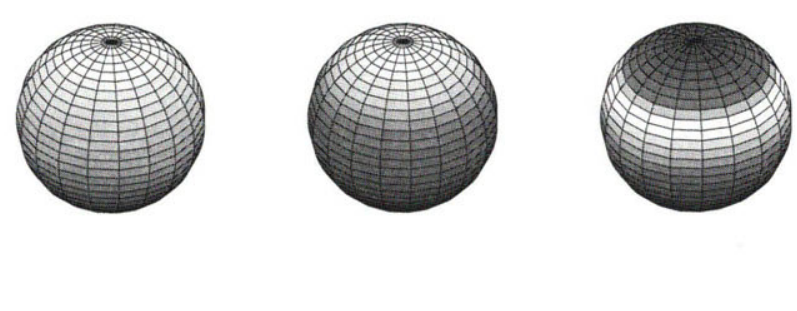
Fig. 4. Surface distribution of the effective temperature near the maximum of the emergent flux for a I — 1 mode and different pressure amplitudes (< 1% left, 5% middle and 20% right). The gray level of the plots are normalized to the maximum T T ff (black) on their e